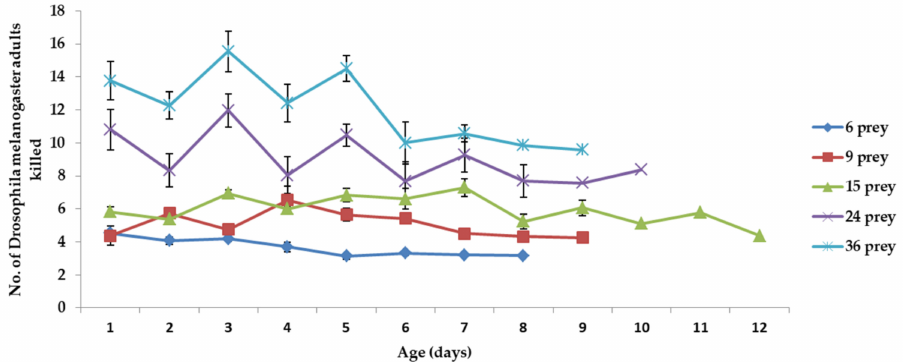
Figure 3. Mean number of prey killed per C. attenuata adult when fed 6, 9, 15, 24 and 36 adults of D. melanogaster daily per predator adult (values are mean ± SE, single values were present when only one adult C. attenuata was left in the